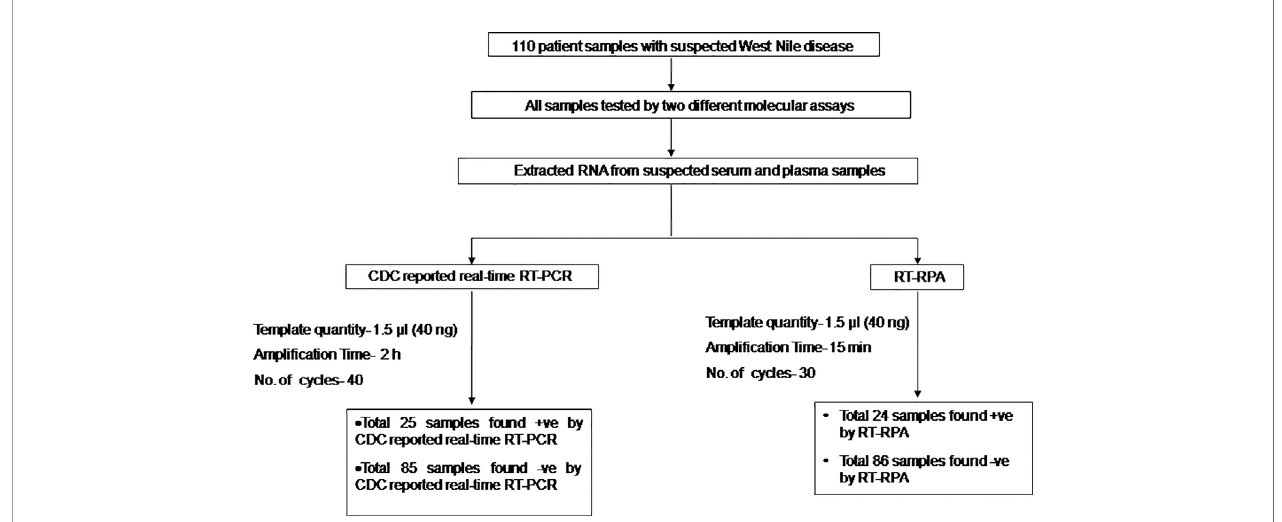
FIGURE 4 | Schematic of the reverse transcription recombinase polymerase ampli fi cation (RT-RPA) comparative evaluation study with West Nile suspected human clinical